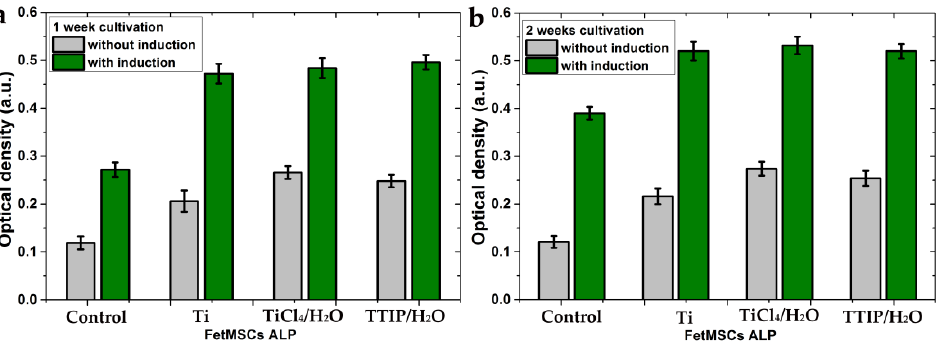
Figure 11. Alkaline phosphatase activity by FetMSCs on the samples with and without a medium induced cellular differentiation in the osteogenic direction after 1 week of cultivation ( a ) and 2 weeks of cultivation ( b ). Each value represents mean ± S.D. from five independent experiments ( p = 0.05). Optical photographs of the MG-63 and FetMSC cells cultivated for 3 weeks on glass slides (control samples) using a Von Kossa stain showed that mineralization of the cells is proceeding. The beginning of mineralization is indicated by black spots corresponding to calcium phosphates (Figure